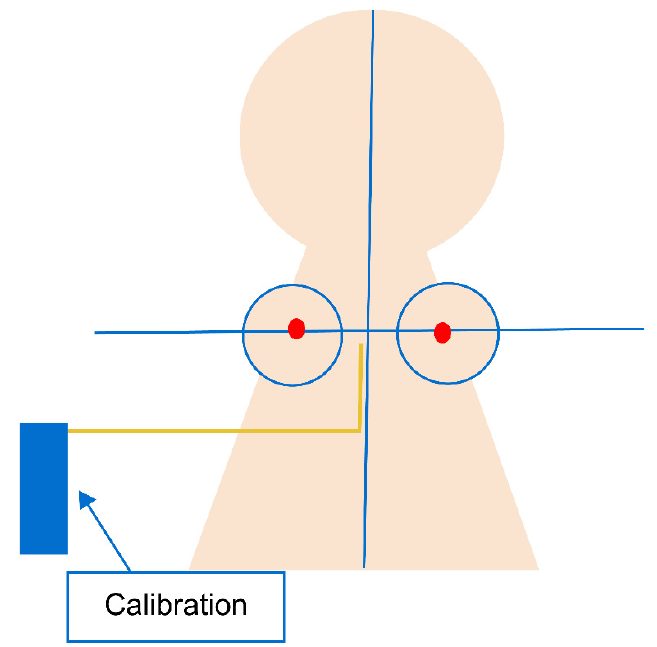
Figure 4. Calibration location for video